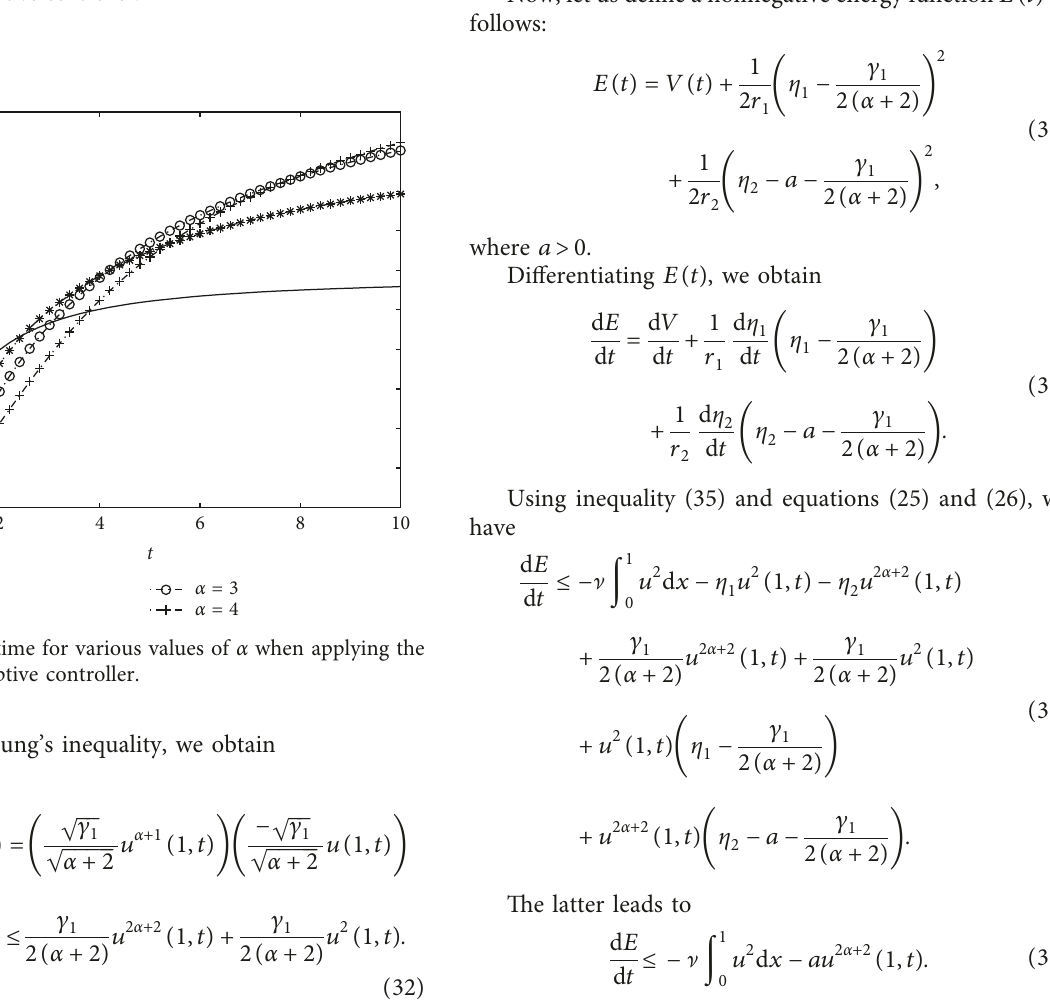
Figure 3: η over time for various values of α when applying the 1 first nonlinear adaptive controller.